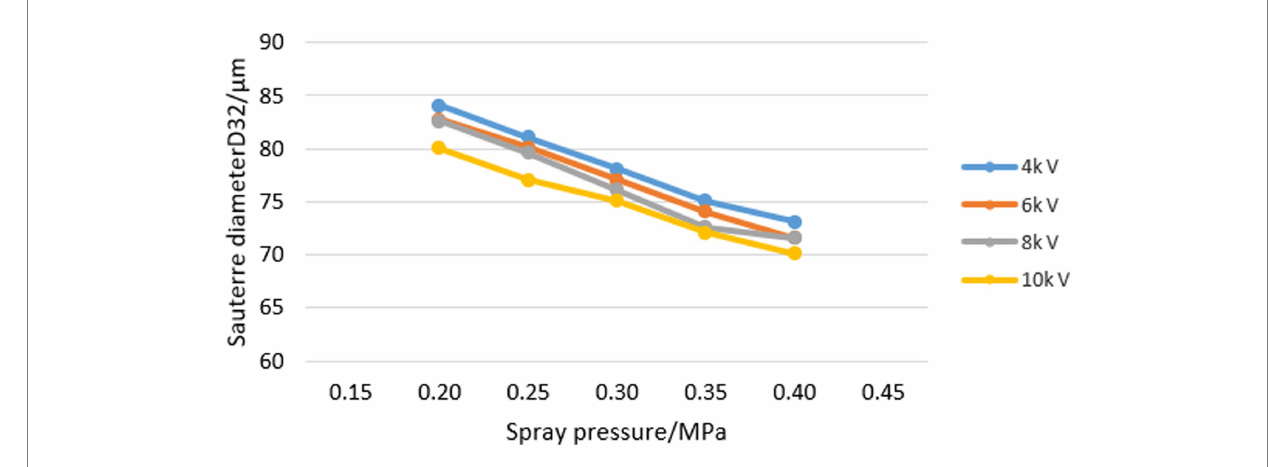
FIGURE 10 Experimental results of spray pressure on particle